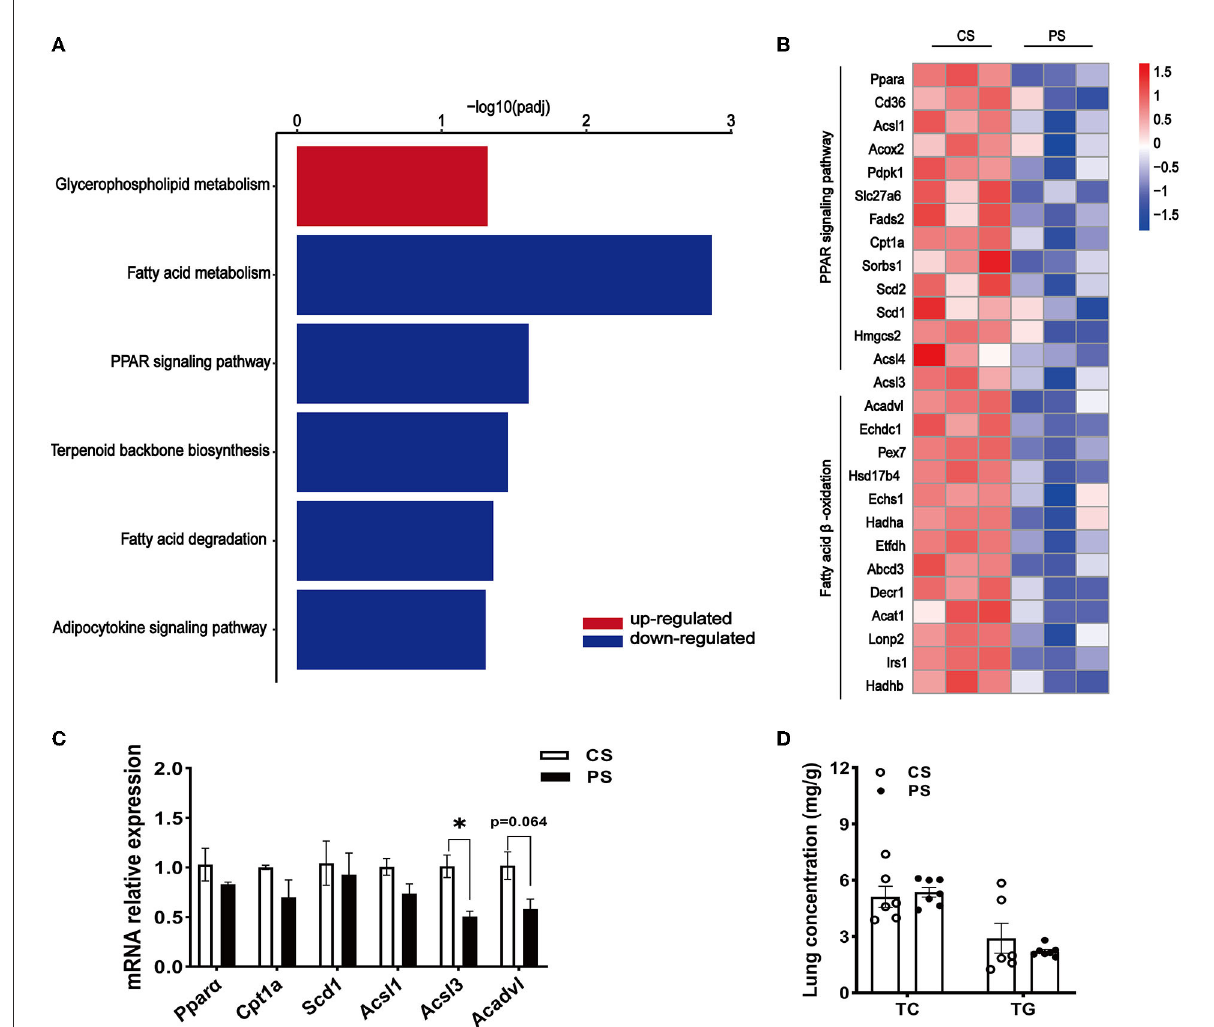
FIGURE8 Changes in fatty acid metabolism transcription profile in the lung of PS diet-fed mice. (A) Representative bar charts of lipid metabolism-related pathways enriched by KEGG analysis in the lung. Red and blue colors indicate upward and downward revisions, respectively. (B) Heatmap profiling the gene expression of genes related to fatty acid transport and oxidation in the lung. (C) Validation of gene expression in the lung derived from RT-qPCR assay. (D) TC and TG concentrations in the lung. n = 3–7 mice/group, the results are presented as the mean ± SEM, representative of three independent experiments, * p <